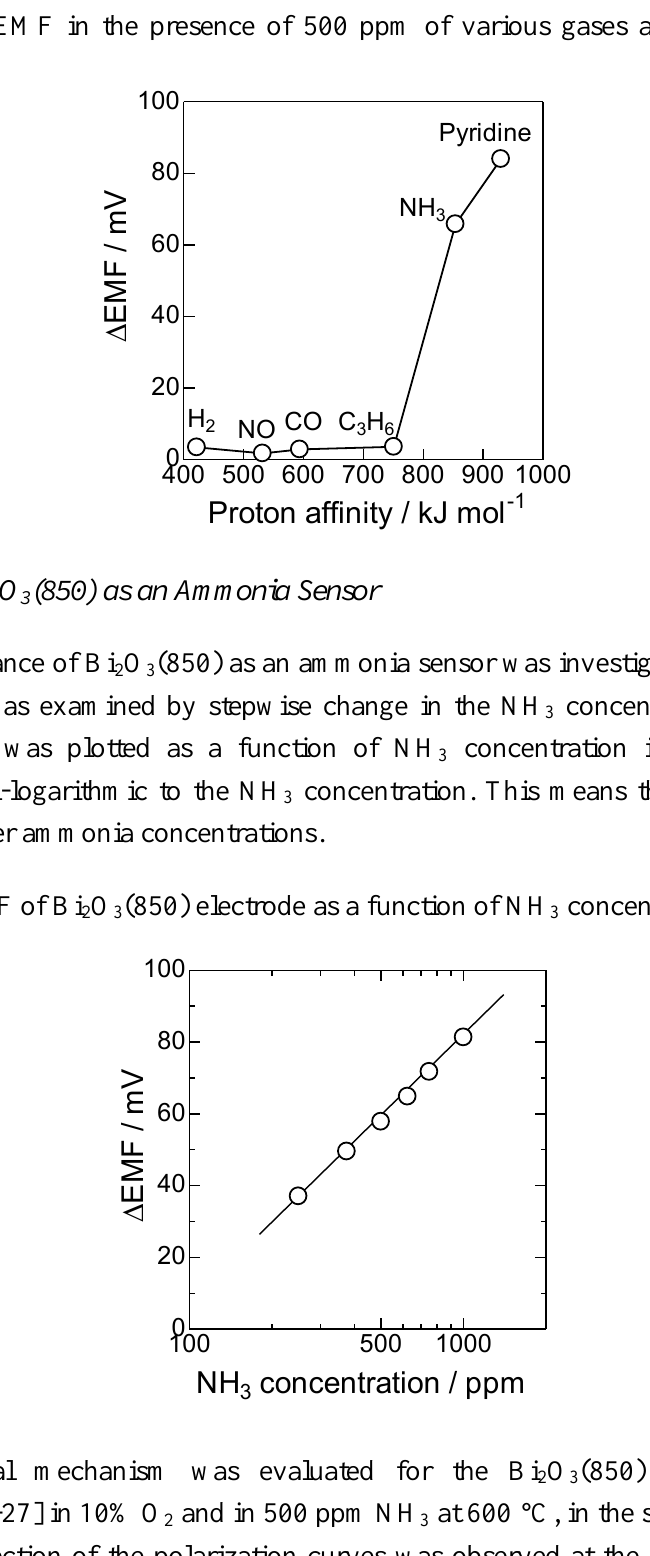
Figure 5. The  EMF in the presence of 500 ppm of various gases as a function of the proton affinity.